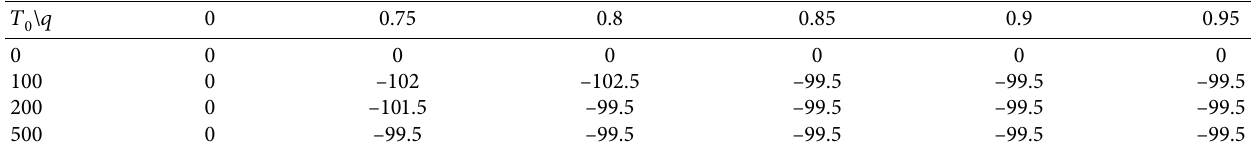
Table 4: Different objective values corresponding to varying SA parameters.